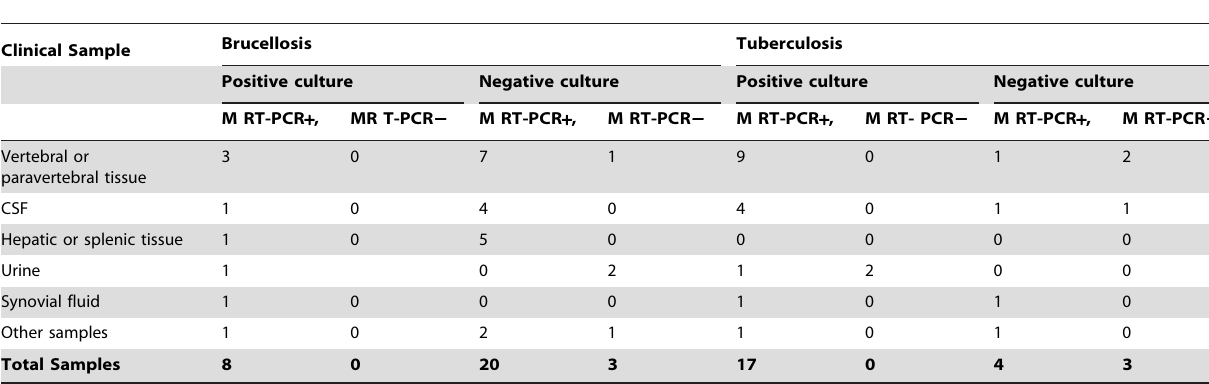
Table 4. Results of M RT-PCR according to clinical sample, microorganism, and culture